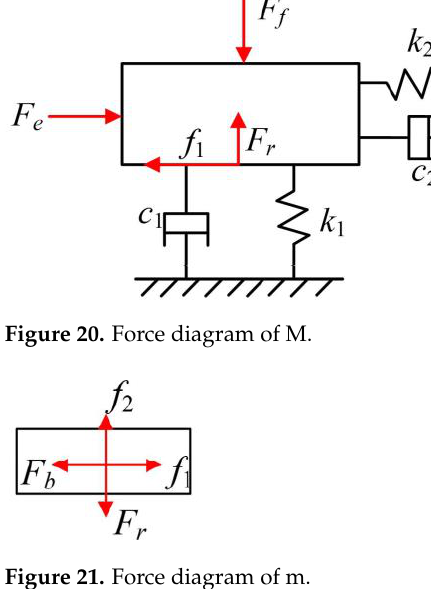
Figure 21. Force diagram of m.